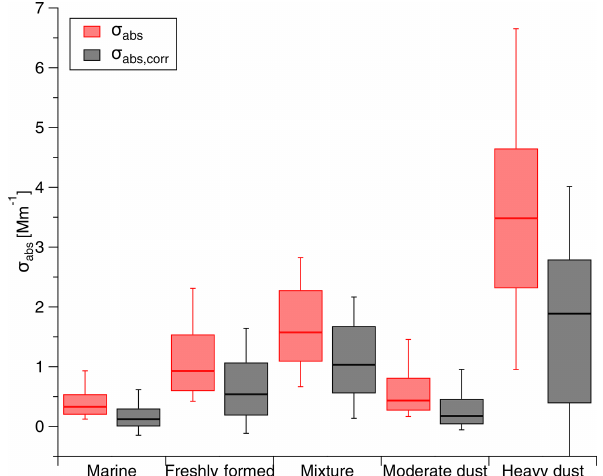
Figure 8. The median and 25th and 75th percentiles of LAC data which were sorted according to the classification obtained from the